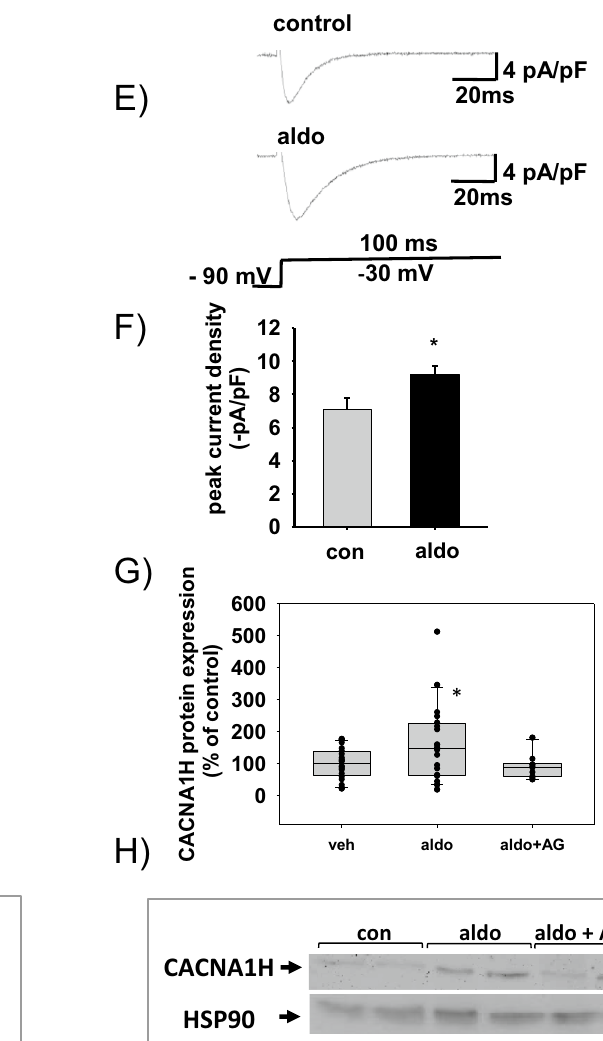
Figure 5. Effect of recombinant EGF, aldosterone and AG1478 treatment on peak current density of I Ca,T and protein expression in HL-1 cells. ( A ) Comparison of characteristic original current traces induced by 100 ms long depolarizations from a holding potential of − 90 mV to a test potential of − 20 mV recorded under control condition (top panel) or after treatment of HL-1-cells with recombinant EGF for 48 h (lower panel). The corresponding pulse protocol is shown in the lower panel. Capacitive transients were partially removed for clarity. ( B ) Statistical evaluation of peak current density of I Ca,T at a test potential of − 20 mV or − 30 mV recorded under control conditions (grey bar, N = 6, n = 59,) and after 48 h long incubation of HL-1 cells with recombinant EGF (black bar, N = 6, n = 46). ( C ) Quantification of protein expression of CACNA1H by Western blot after stimulation of HL-1 cells with vehicle, 10 µg/l EGF, 1 µM AG1478 or EGF and AG1478. * p ≤ 0.05. ( D ) Representative Western blot showing expression of CACNA1H after stimulation of HL-1 cells with vehicle, 10 µg/l EGF, 1 µM AG1478 or EGF and AG1478. ( E ) Comparison of typical original current traces induced by 100 ms long depolarizations from a holding potential of − 90 mV to a test potential of − 30 mV recorded under control condition (top panel) or after treatment of the cell with 10 nM aldosterone for 48 h (lower panel). ( F ) Statistical evaluation of peak current density of I Ca,T at a test potential of -20 mV or -30 mV recorded under control conditions (grey bar, n = 31, N = 6) and after 48 h long incubation of HL-1 cells with 10 nM aldosterone (black bar, N = 6, n = 34). ( G ) Quantification of protein expression of CACNA1H by Western blot after stimulation of HL-1 cells with vehicle, 10 nM aldosterone or 1 µM AG1478 and aldosterone. * p ≤ 0.05. ( H ) Representative Western Blot showing expression of CACNA1H after stimulation of HL-1 cells with vehicle, 10 nM aldosterone or a combination of aldosterone and AG1478, * p ≤